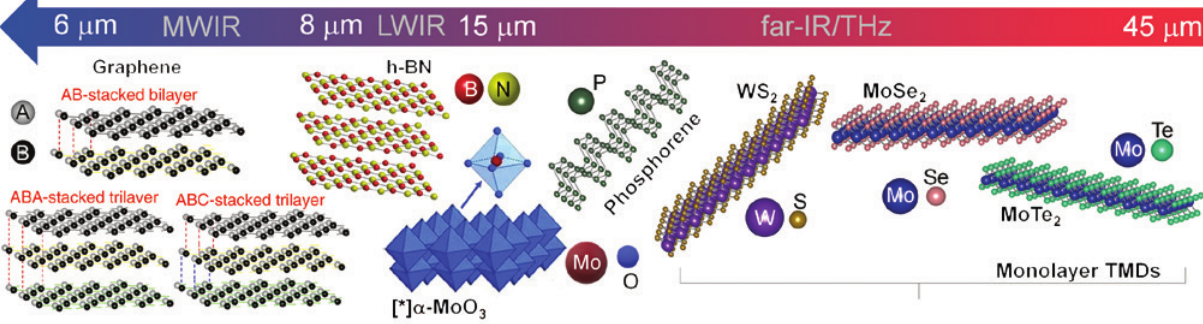
Figure 12: Atomically-thin PhP materials. The PhP responses of the examples shown fully cover the spectral regime between 6 μ m and 45 μ m (free-space wavelength). The material schematics are placed in order of decreasing wavelength (from right to left) of the associated IR active optical phonons (see top arrow; note: wavelength scale is not linear/proportional). [*] The α -MoO schematic is adapted from [164] via CC BY 4.0 license (see link at https:// 3